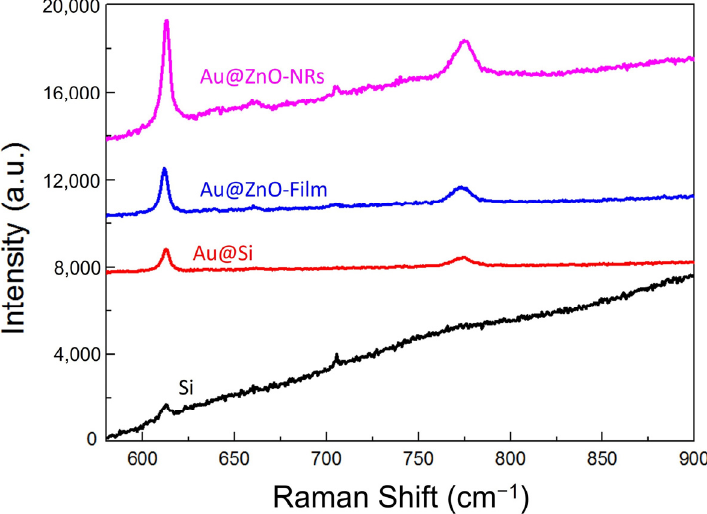
Figure 7. Raman spectra at 612 cm − 1 detected from three kinds of substrates with a sputtering time of 160 s, and from Si substrate.